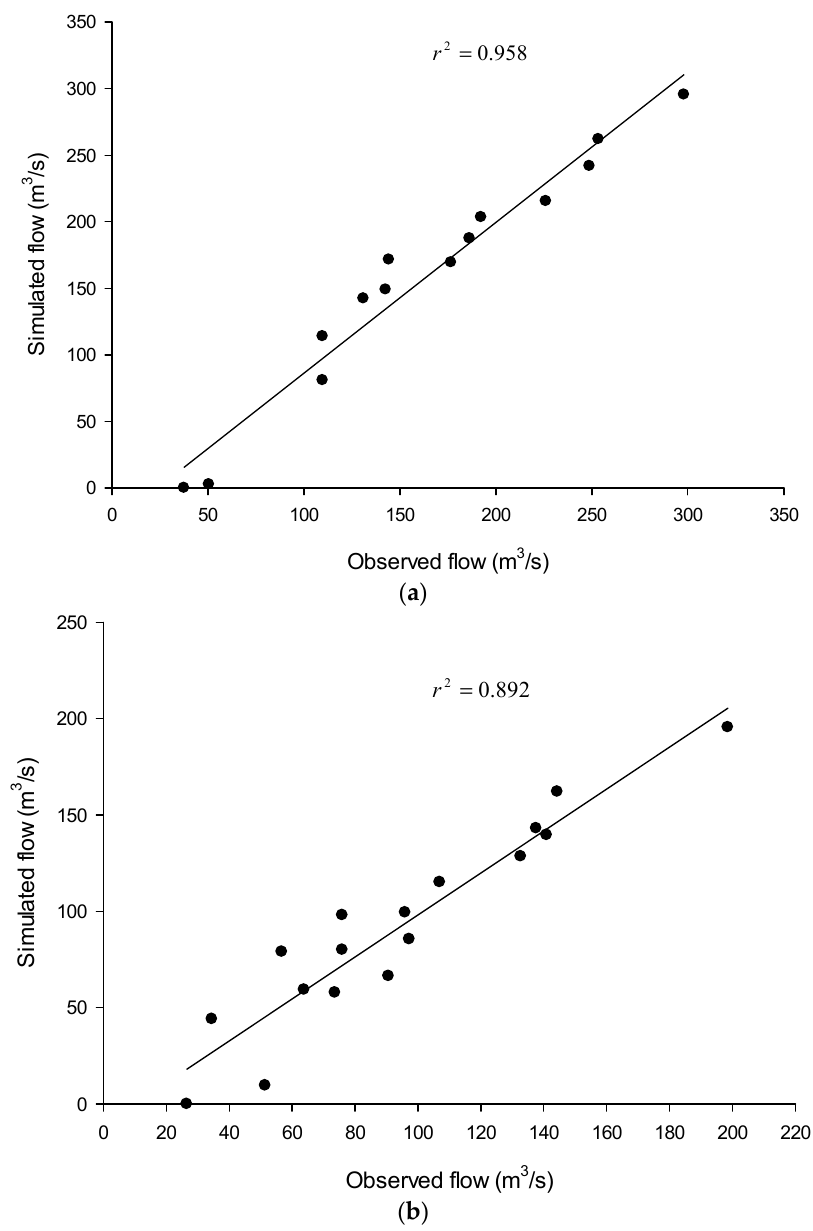
Figure 5. Correlation between observed and simulated flow values after validation ( a ) Event 7 (02–15 August, 2008) and ( b ) Event 9 (04–20 July,